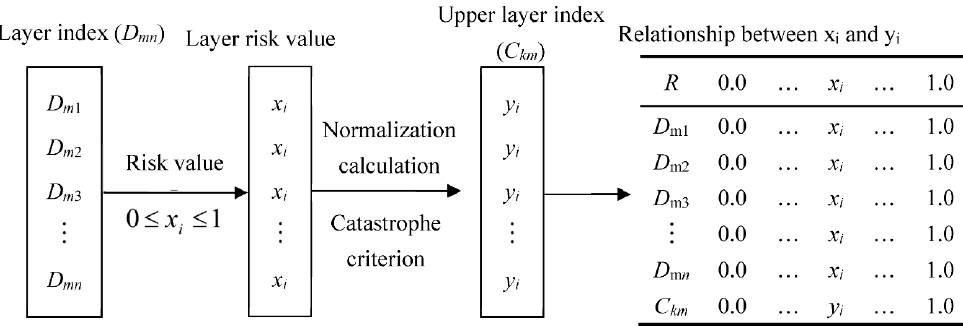
Figure 1. Conversion method for index risk value xi and catastrophe subordinate function yi at each level.